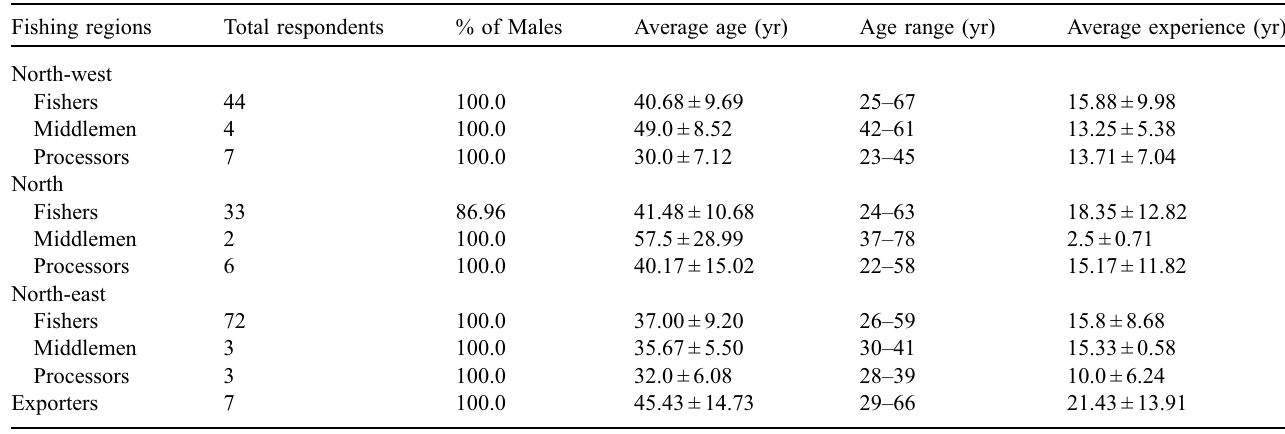
Table 5. Socio-demographic characteristics of sea cucumber fi shers in the north-west, north and north-east coasts of Sri